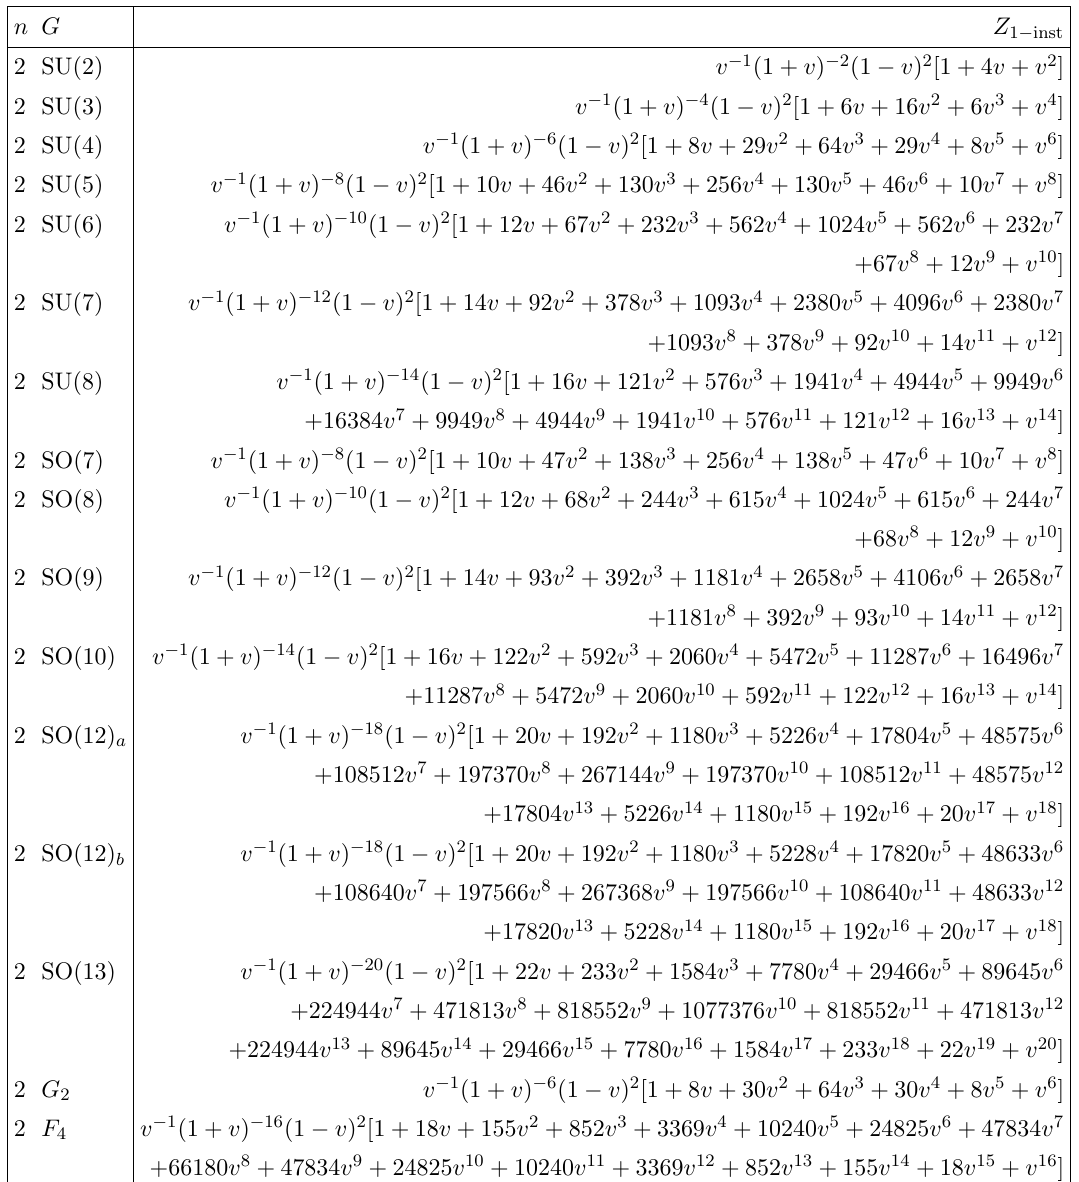
with n = 2, with chemical n